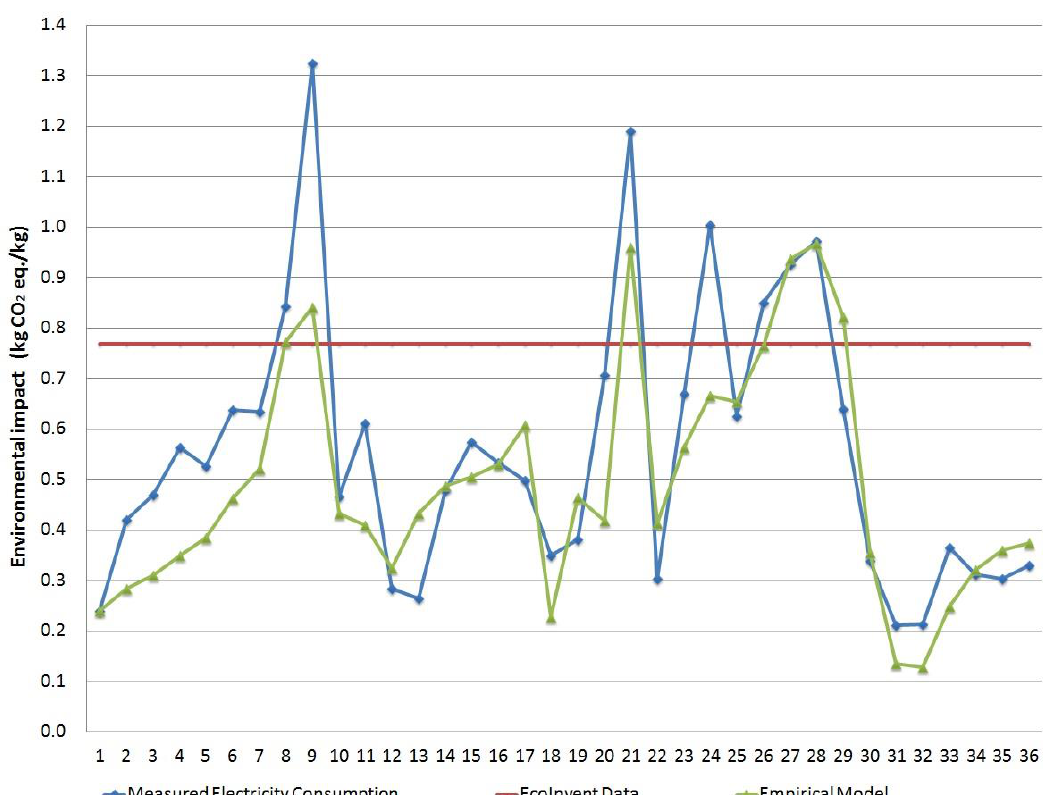
Figure 4. Comparison of modeled, measured, and EcoInvent data for the environmental impact assessment (kg equivalents of CO 2 ). assessment (kg equivalents of CO 2